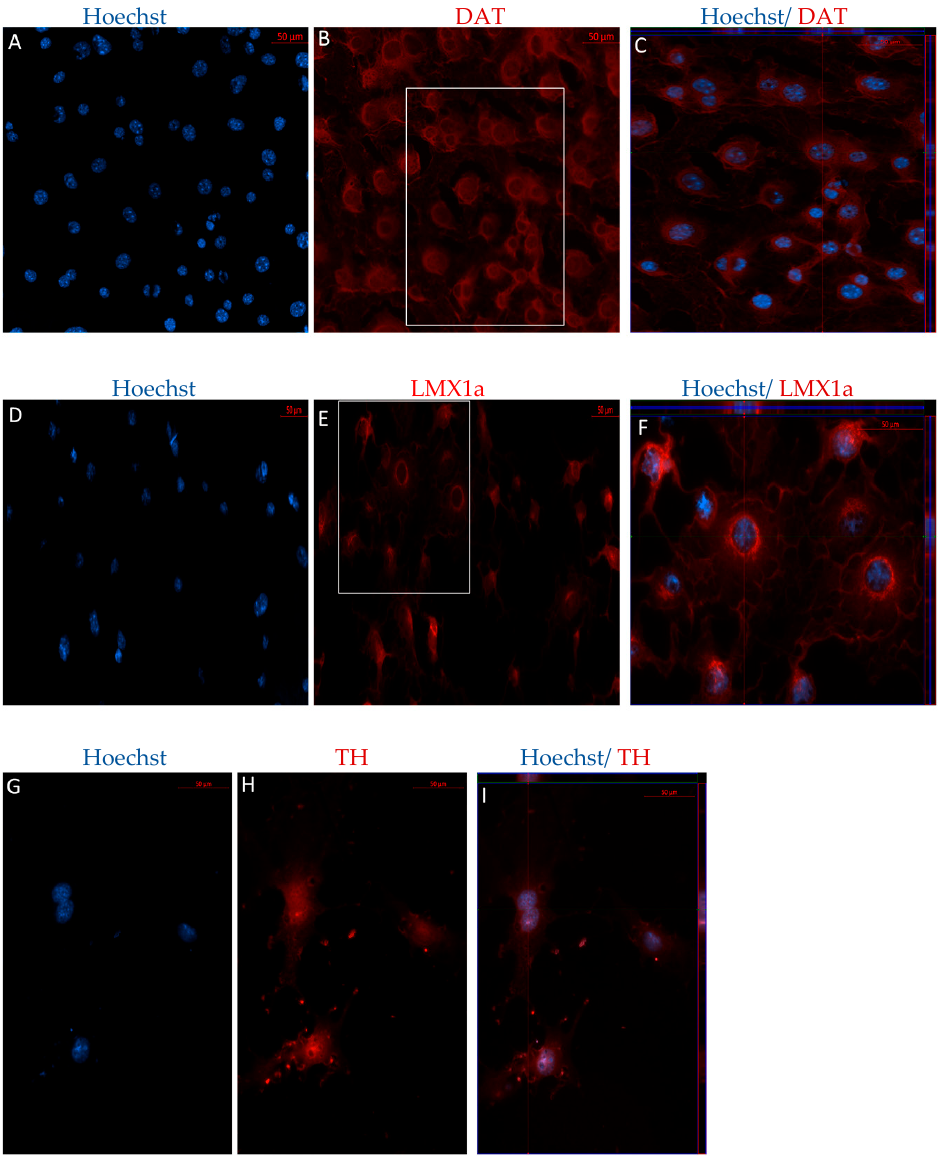
Figure 4. Immunocytochemistry/immunofluorescence (ICC/IF) performed on P4 MSCs following the DDI. Hoechst-labeled P4 MSCs ( A , D , G ) revealed positive staining of the mature dopaminergic markers DAT (( B ) red) and TH (( H ) red), and the immature dopaminergic marker LMX1a (( E ) red), following exposure to SHH, FGF-8, bFGF, and BDNF. Orthogonal displays of z -stacks are represented in merged images ( C , F , I ).